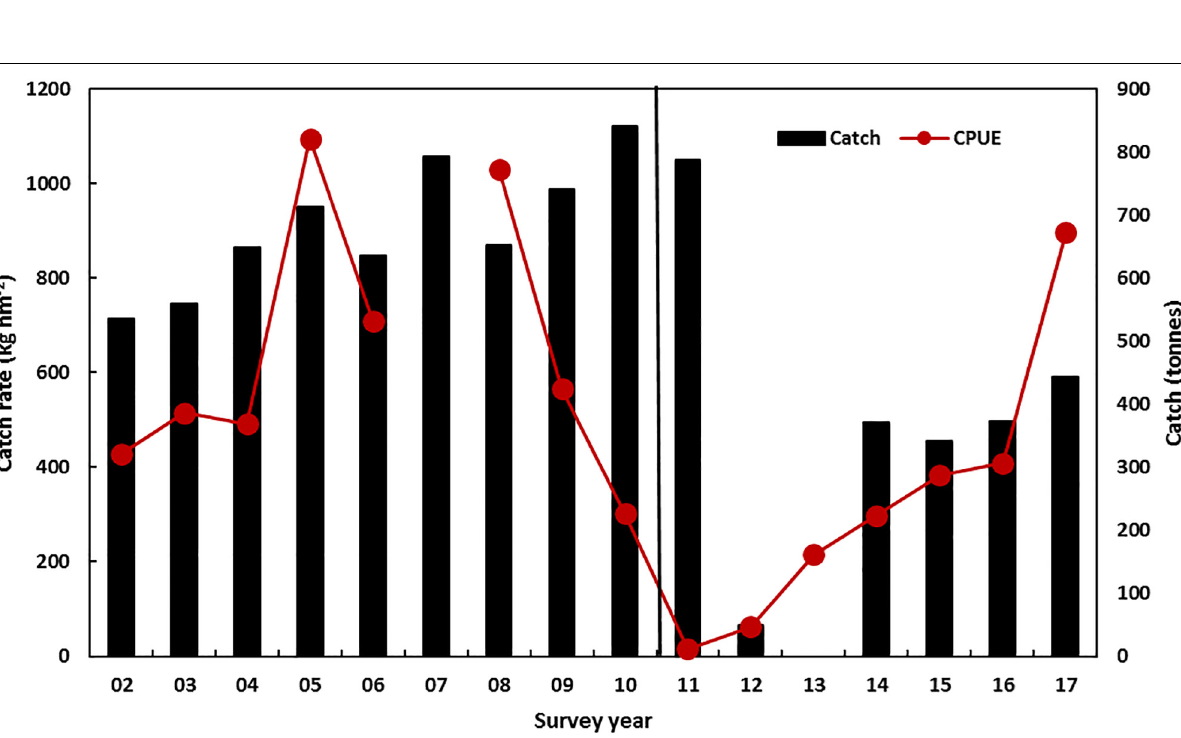
Frontiers in Marine Science |